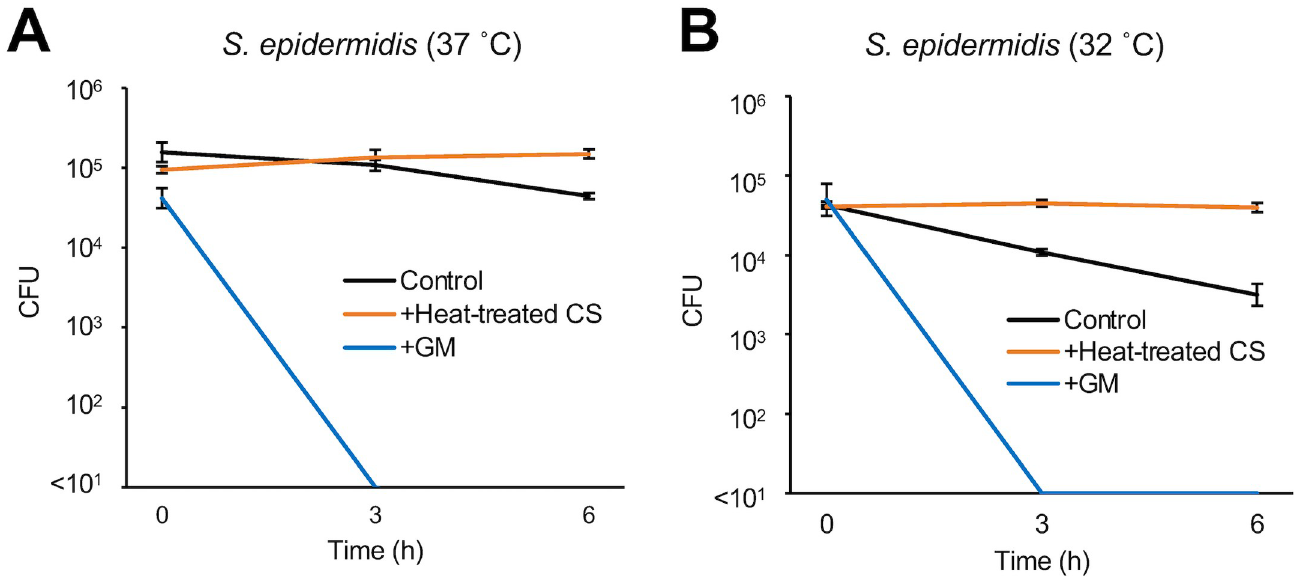
Fig 3. Time-kill assay of heat-treated culture supernatant of D . acidovorans against S . epidermidis . S . epidermidis (1 × 10 5 cells/mL) in PBS was mixed with 20% NB (Control), 20% D . acidovorans heat-treated CS (Heat-treated CS), and 10 μ g/mL gentamicin (GM) at 37˚C (A) or 32˚C (B). Each line shows the number of viable cells of S . epidermidis at 0, 3, and 6 h. Error bars indicate the SD of the means (n = 3).